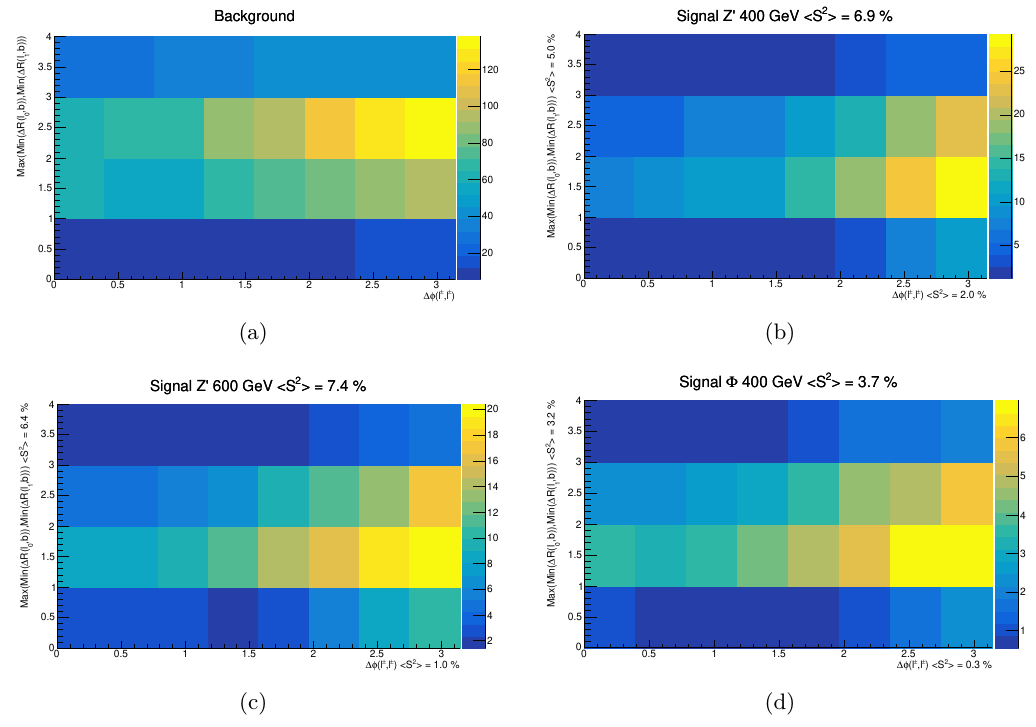
Figure 15 . Simulated event yields for different processes in the two dimensional space formed by the azimuthal angular distance between the two same-sign leptons (x-axis) and the MaxMin ( ‘, b ) observable (y-axis). When comparing the reported separations to those in figures 13 and 14, one should take into account that this is for the global selection, not Region